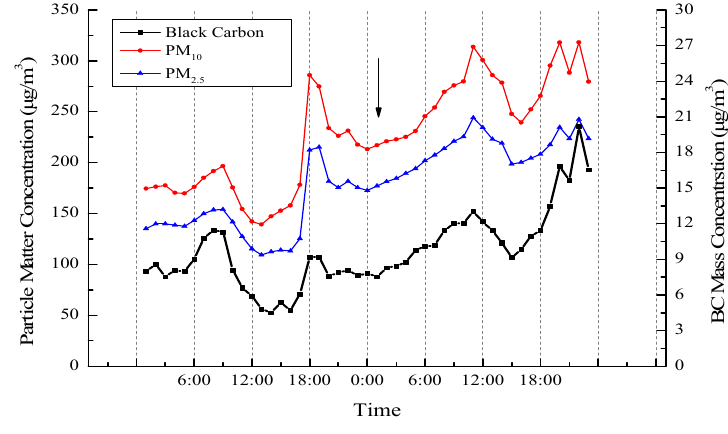
Figure 7. Diurnal variation in mass concentrations of PM 2.5 , PM 10 and BC in